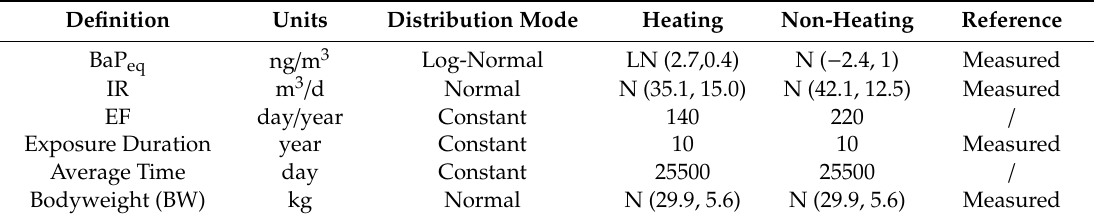
Parameter distribution types used in the Monte Carlo simulation during